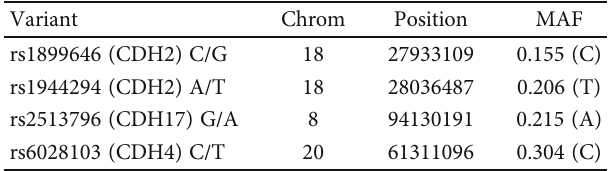
Table 1: Physical locations of the 4 cadherin gene